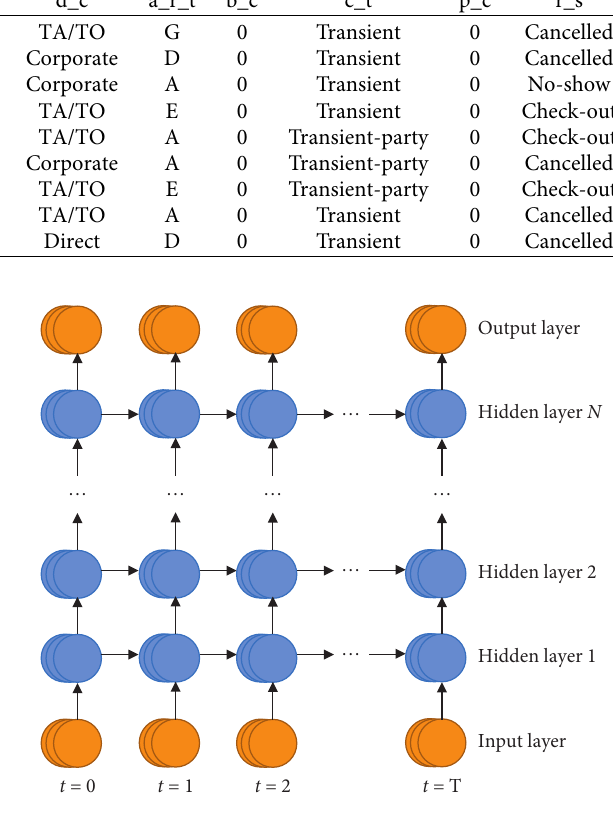
Figure 1: RNN structure unfolded along time